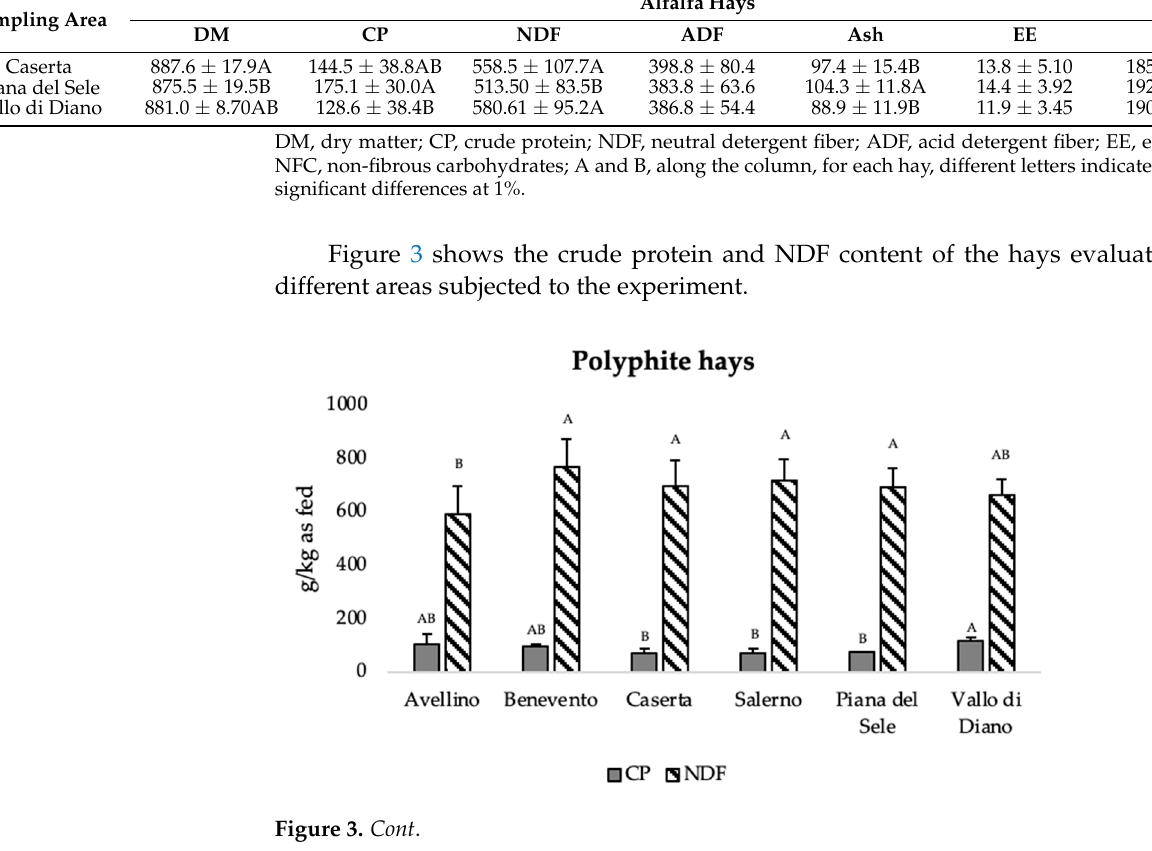
Figure 3. Crude protein and neutral detergent fiber content of the analyzed hays (polyphite, Gra- mineae and alfalfa) comparing the different sampling areas. CP, crude protein; NDF, neutral deter- gent fiber; A and B, different letters indicate statistically significant differences at 1%. 4. Discussion A fast knowledge of the nutritional value of dairy farm forage is critical for livestock. A specialized laboratory is generally needed for quality evaluation, being rather expen- sive and involving a high amount of time and work. For these reasons, faster and easier